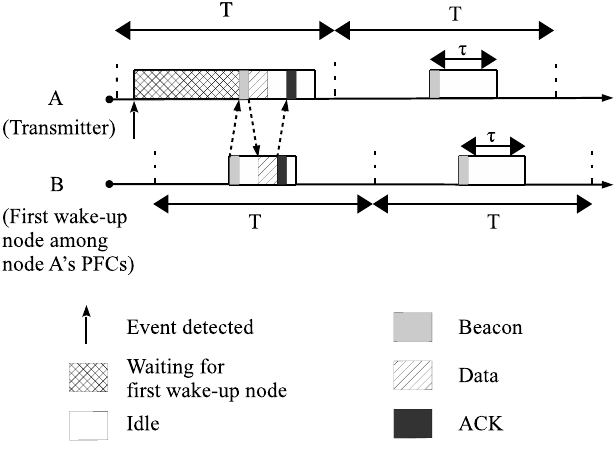
Figure 2. Example of data transmission